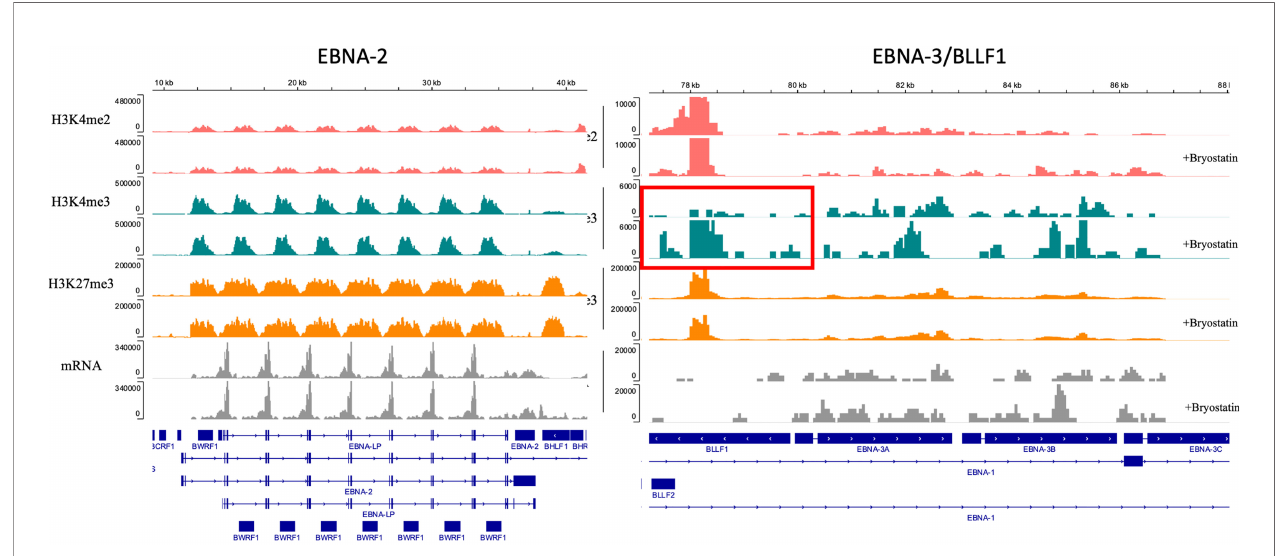
FIGURE 10 | Epigenetic modulation of the EBV genome in Raji leukemia cells mediated by bryostatin. Sequenced reads for transcriptional activators of EBV latency, left panel) EBNA-2 and EBNA-LP, and right panel) EBNA-3A,-3B,-3C and BLLF1; were analyzed by Cut&Tag analysis and mapped on the EBV genome for the presence of epigenetic modi fi cation of H3K4me2, H3K4me2, and H3K27me3 (y-axis). No reads were detected for the IgG control. Reads are presented as parallel samples for bryostatin-treated (+bryostatin) or untreated Raji. Shown below the immunoprecipitated Cut&Tag reads are total mRNA reads (in gray) displayed over the relevant portion of the EBV viral genome, shown at the bottom portion of the plot. Changes demonstrated for H4K4me3 reads for BLLF1 are indicated by the red